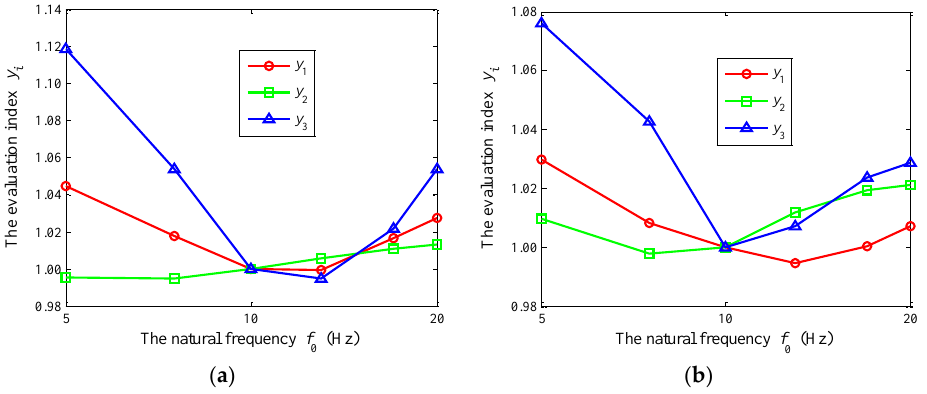
Figure 17. The evaluation index y i versus the natural frequency f 0 for the wheelchair: ( a ) going up the step; ( b ) going down the step.